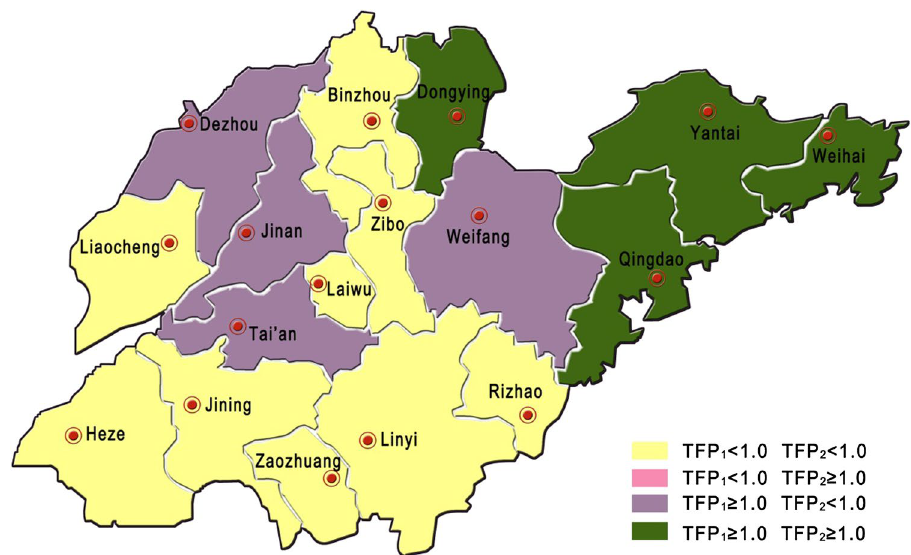
Table 5 Influence factors of water use efficiency of 17 cities during the 12th Five-year Plan